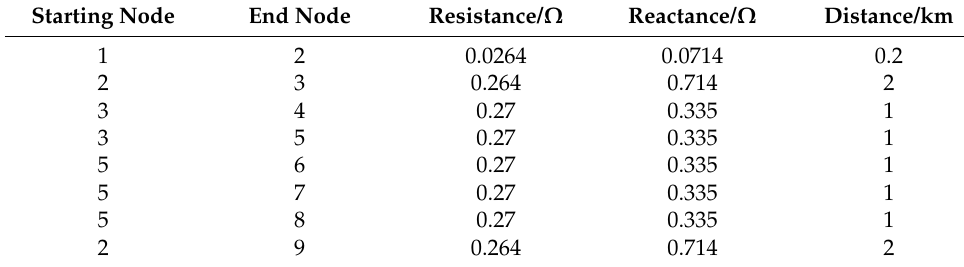
Table A2. Line parameters of distribution